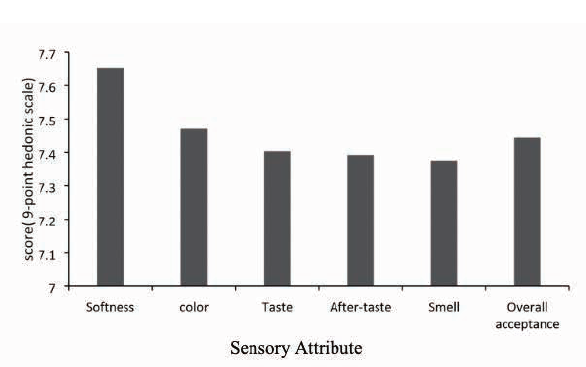
Figure 1: Sensory acceptance of OFSP